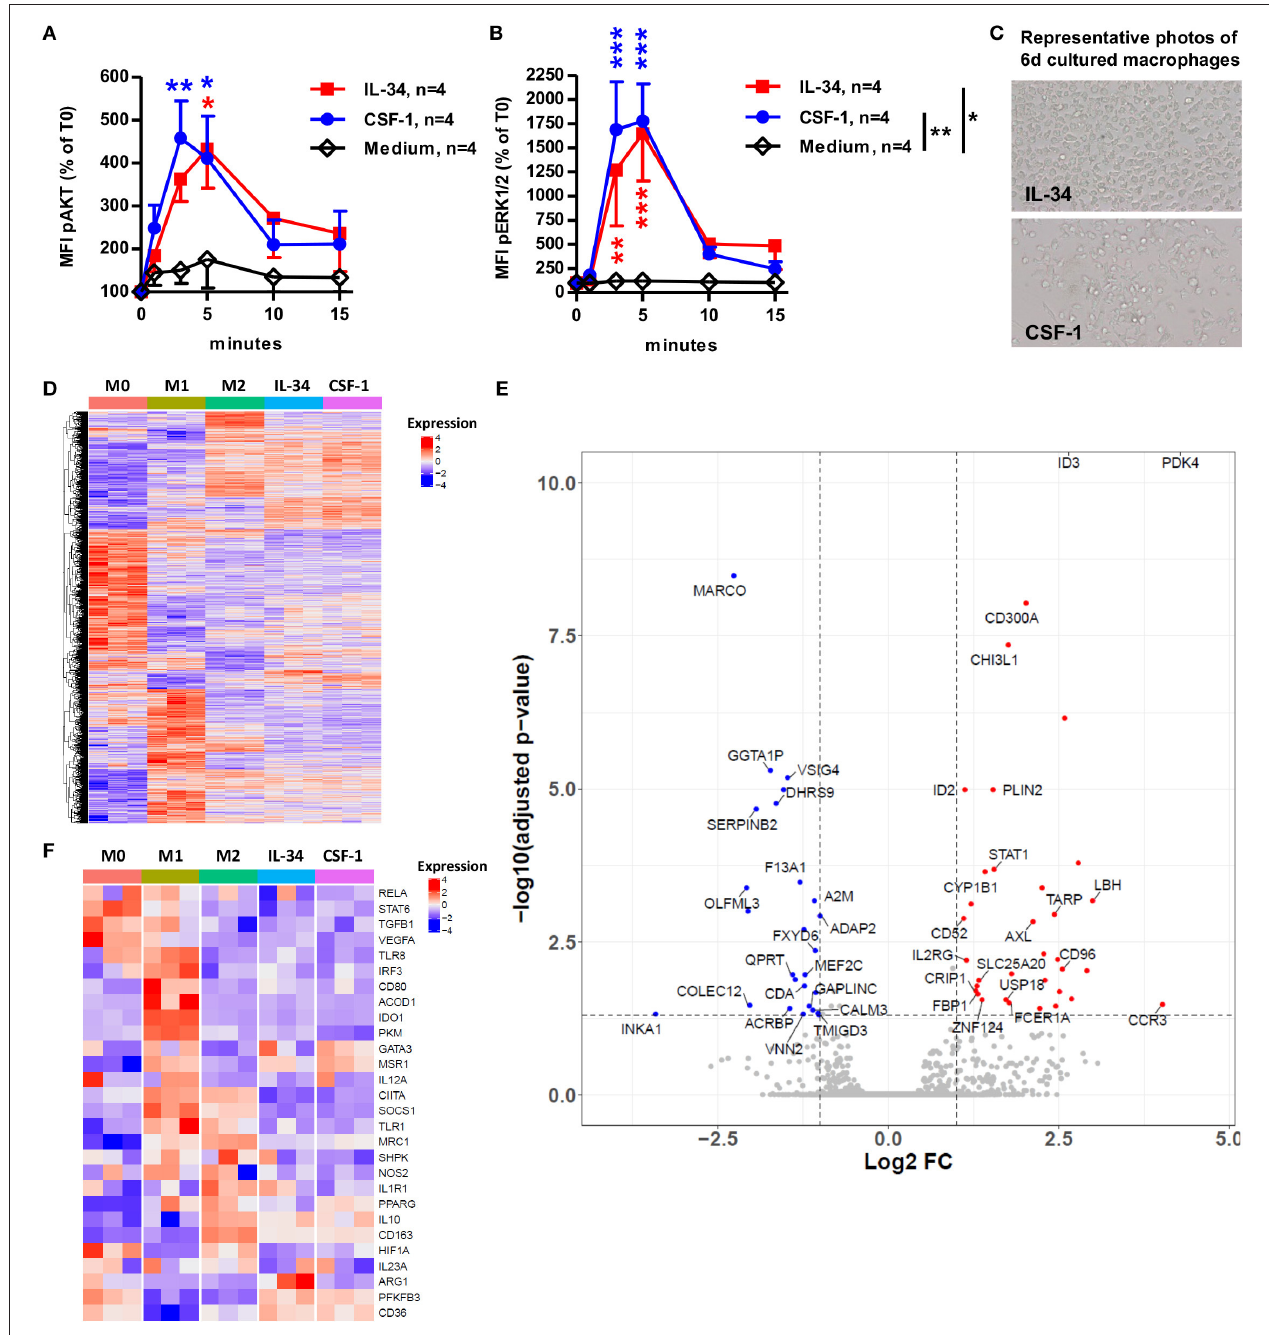
FIGURE 3 | IL-34-induced macrophages display a transcriptome close, but not identical, to M2-type and CSF-1-induced macrophages. (A,B) CD14 ++ monocytes were cultured with IL-34 or CSF-1 for 1, 3, 5, 10, and 15min and analyzed for phosphorylation of AKT (A) and ERK1/2 (B) by flow cytometry. Results are represented as a percentage of baseline levels (T0). n = 4 individuals. Two-way ANOVA and Bonferroni post-test compared to medium alone. * p < 0.05, ** p < 0.01, *** p < 0.001. (C) Photos of CD14 ++ monocytes after 6 days of culture in the presence of IL-34 or CSF-1. X20 magnification. (D–F) CD14 ++ monocytes were cultured for 6 days with IL-34 or CSF-1 and analyzed by DGE-RNAseq for gene expression. (D) Expression levels of differentially expressed genes between each condition are presented as a heatmap. Each column represents one sample. Blue color represents low expressed genes and red color represents highly expressed genes. The color bar shows experimental conditions. M0 are freshly sorted monocytes. (E) Volcano plot highlighting overexpressed genes (on the right, red dots) and under-expressed genes (on the left, blue dots) in IL-34-differentiated macrophages as compared with CSF-1-differentiated macrophages. The p -value adjusted cut-off is 0.05. (F) Heatmap representing expression of M1 and M2 macrophage genes in samples. Gene expression was normalized with regularized log transformations (rlog) algorithm (Deseq2), center and scaled. Blue color represents low expressed genes and red color represents highly expressed genes. Supervised clustering was performed to order samples. The color bar corresponds to experimental